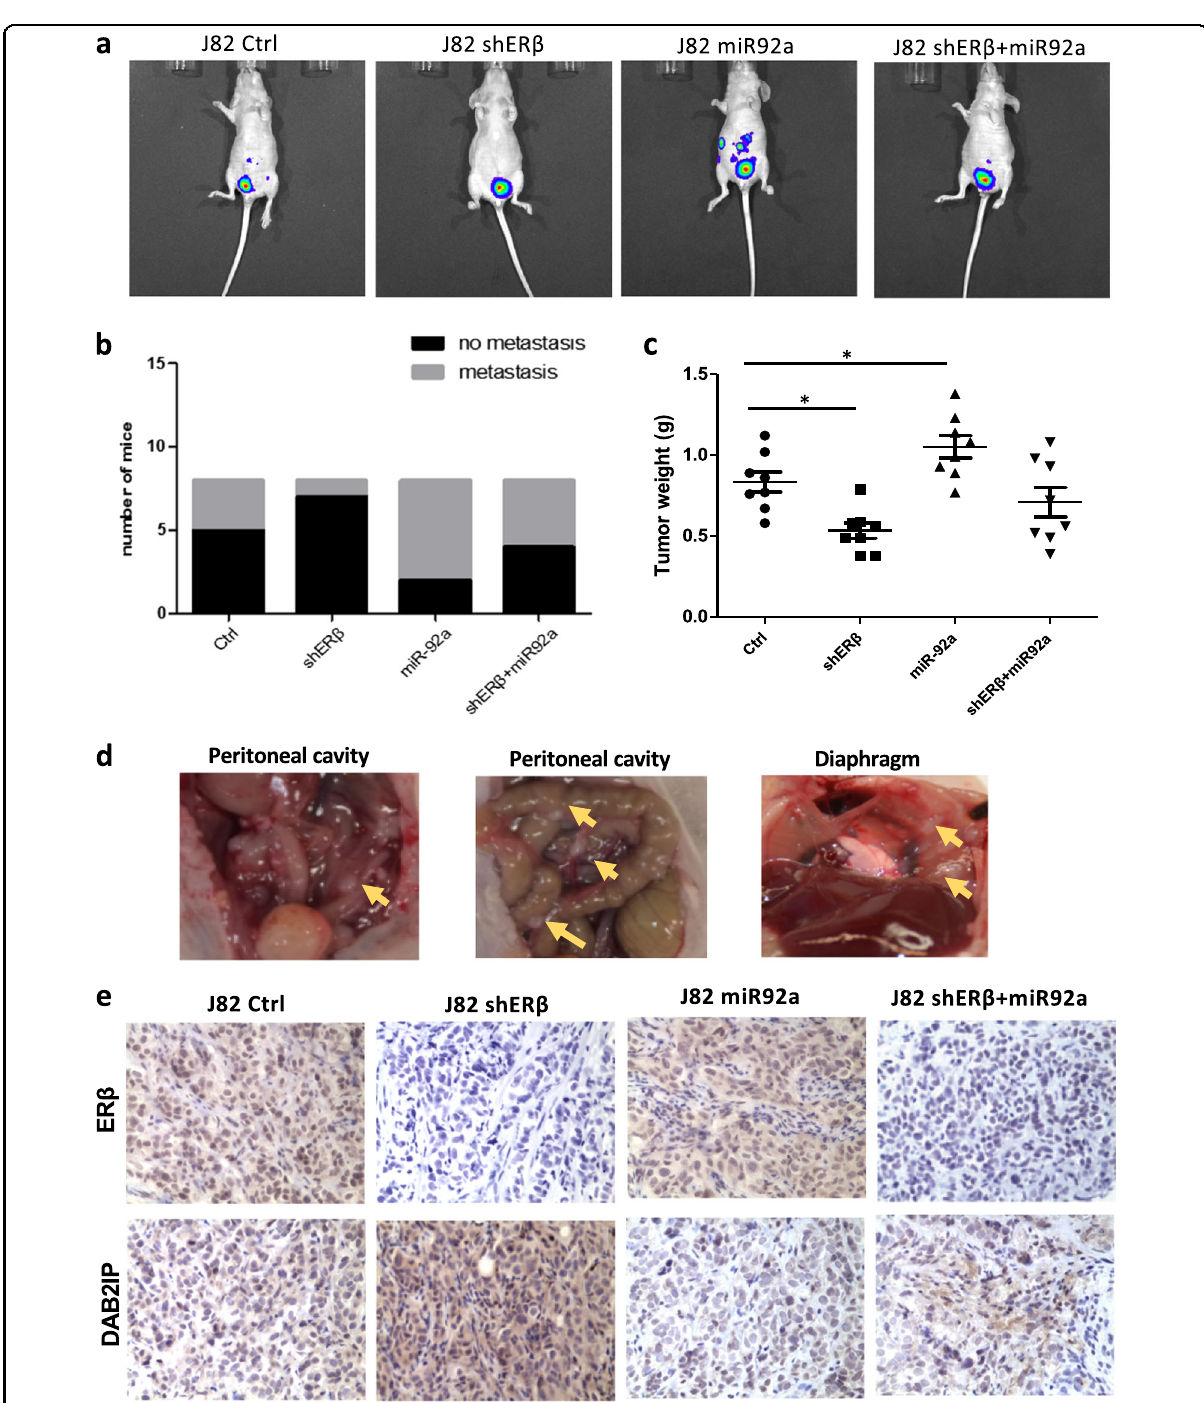
Fig. 5 ER β promotes metastasis of BCa via up-regulation of miR-92a and down-regulation of DAB2IP in the in vivo mouse BCa model. The implanted J82 cells were stably transfected with pCDNA3-luciferase (J82-Luc) for monitoring of tumor growth and metastasis via the real-time in vivo imaging system (IVIS). a Representative IVIS images of the four groups of mice showed the outcome at eight weeks after orthotopical implantation of BCa J82-luc cells into the bladder wall of female nude mice. b Incidence of metastases in different groups of mice at eight weeks after BCa cell implantation. c Comparison of bladder weights of different mouse tumor groups. d The images show representative metastatic lymph foci (yellow arrows) around the peritoneal and diaphragm regions. e Representative images of IHC results for ER β and DAB2IP in four groups of orthotopic bladder tumor tissues (400× ). In c , data are presented as the mean ± SD, * P <